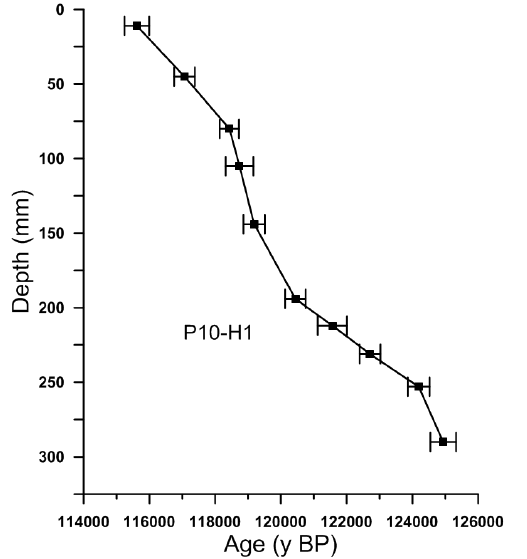
Figure 2. δ 18 O values for P10-H1 from Huagapo Cave in Peru plot- ted together with δ 18 O values for stalagmites from Hulu Cave in China (Kelly et al., 2006) and the insolation curve for 10 ◦ S in Jan- uary (Berger,